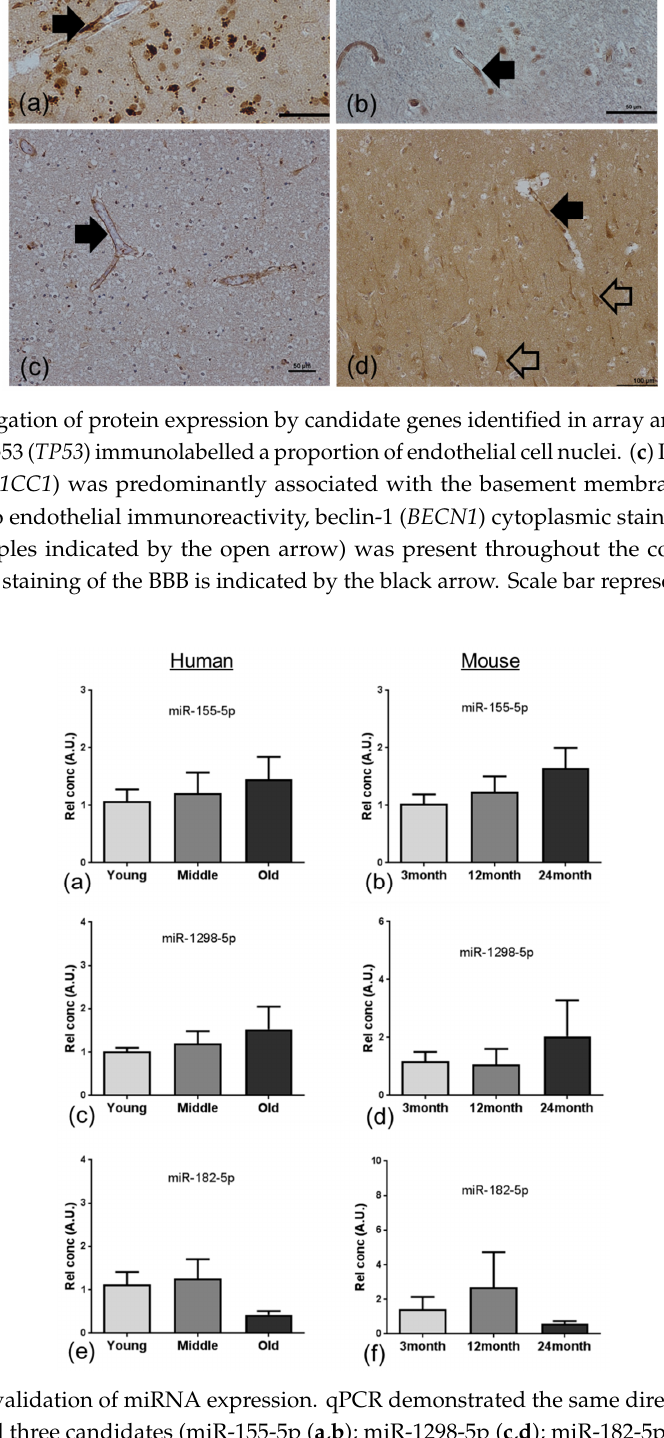
Figure 6. qPCR validation of miRNA expression. qPCR demonstrated the same directional change of expression for all three candidates (miR-155-5p ( a , b ); miR-1298-5p ( c , d ); miR-182-5p ( e , f )) in both the human ( a , c , e ) and mouse ( b , d , f ) groups, similar to the directional change observed in the microarray analysis. Only miR-182-5p in human samples was significantly altered (ANOVA p = 0.032). Data presented as mean ± SEM.